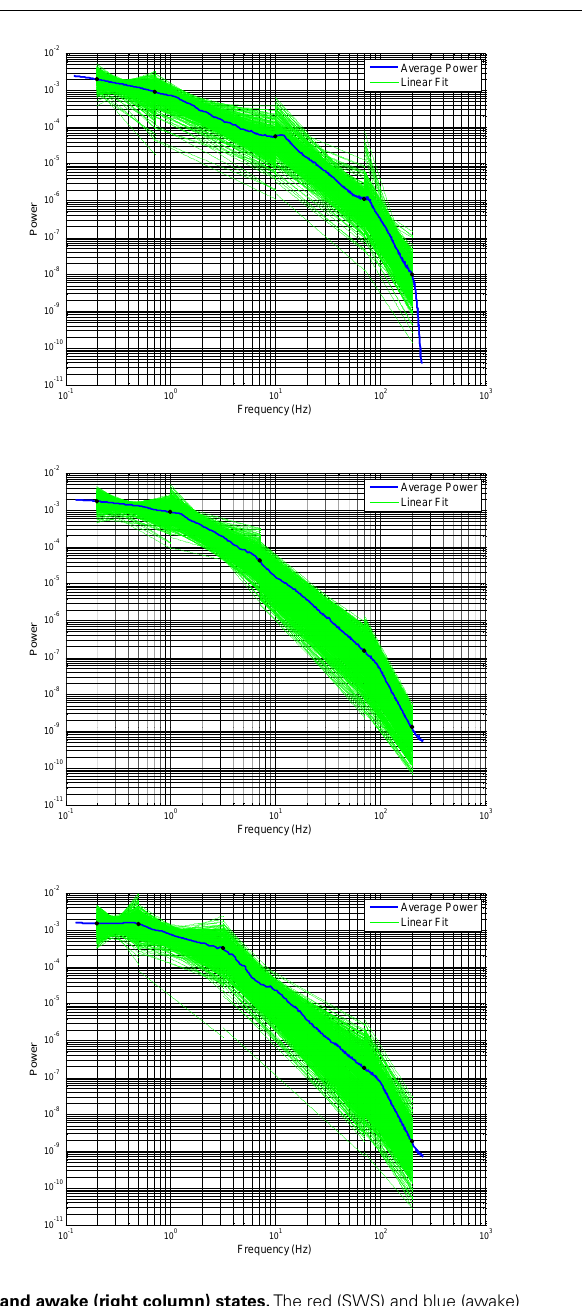
FIGURE 6 | Foursegment piecewise linear fits of PSD slopes by 30s time interval and electrode plotted in green for each subject (one to six in orderA–F, respectively) in both SWS (left column)